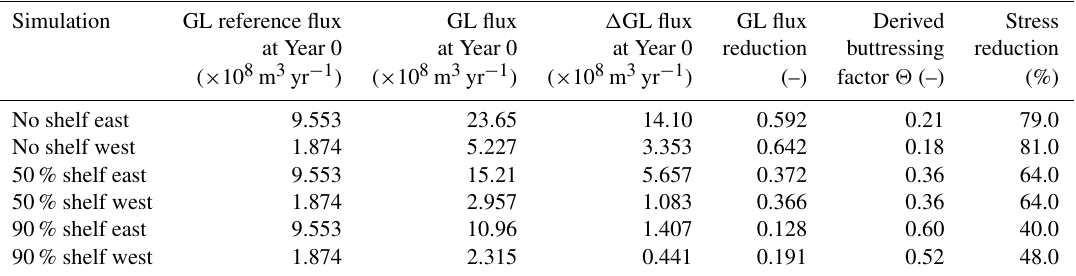
Table 3. Flux calculations, derived buttressing factors, and stress reduction calculations for both sides of the divide for the Halvfarryggen Ice Rise from runs 8 and 10–11 (Table 2). GL flux reduction in relation to the shelf thickness perturbation simulations (column 2) is computed by dividing (cid:49) GL flux (column 3) by GL flux (column 2), and the buttressing factor and stress reduction are calculated from Schoof (2007) (Eq.